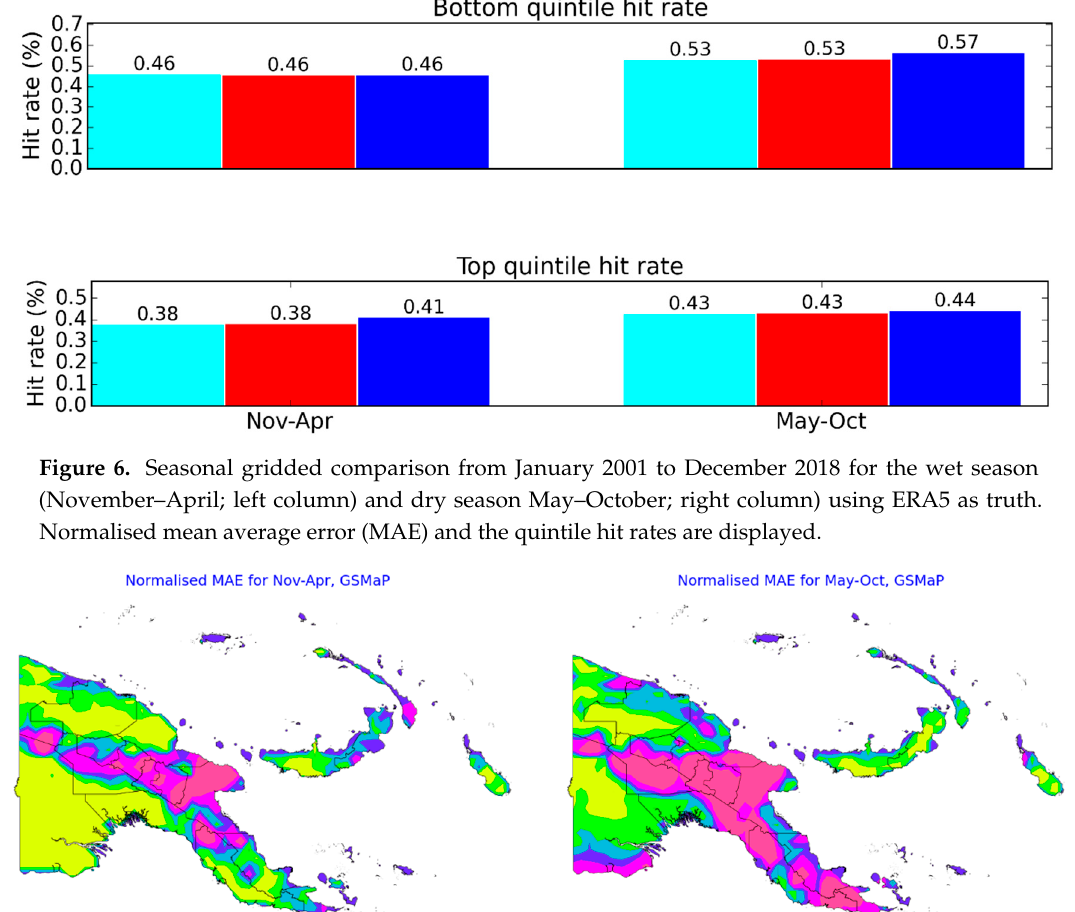
Figure 7. Seasonal gridded areal comparison from January 2001 to December 2018 using ERA5 as truth. Normalised mean average error (MAE) is displayed.